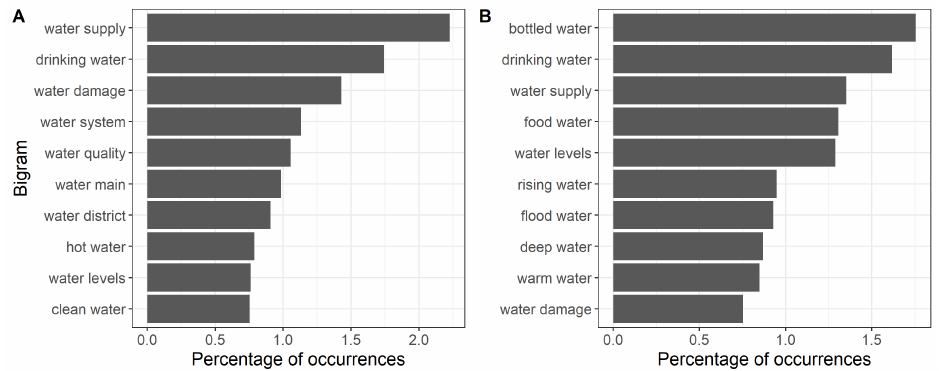
Figure 4. Top 10 Water Concerns during Fires ( A ) and Hurricanes ( B ). Water quality issues are more prominent for fires, while food and water issues are more prevalent during hurricanes.